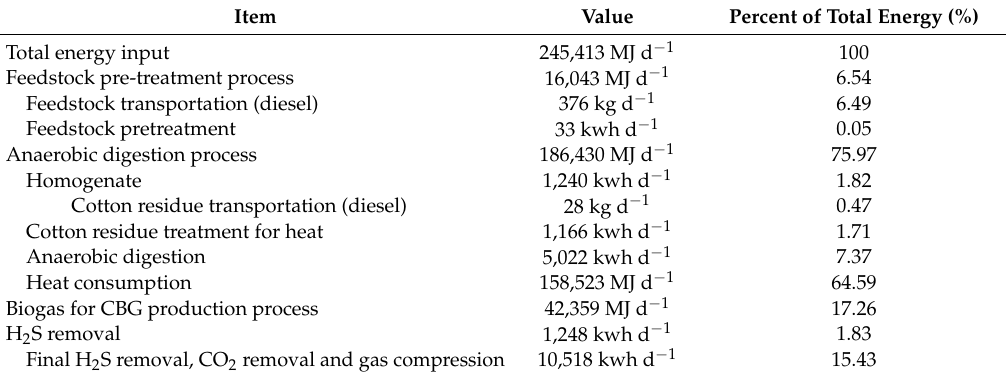
Table 3. Energy efficiency of the manure co-digestion with corn stover for compressed bio-natural gas (CBG) production system